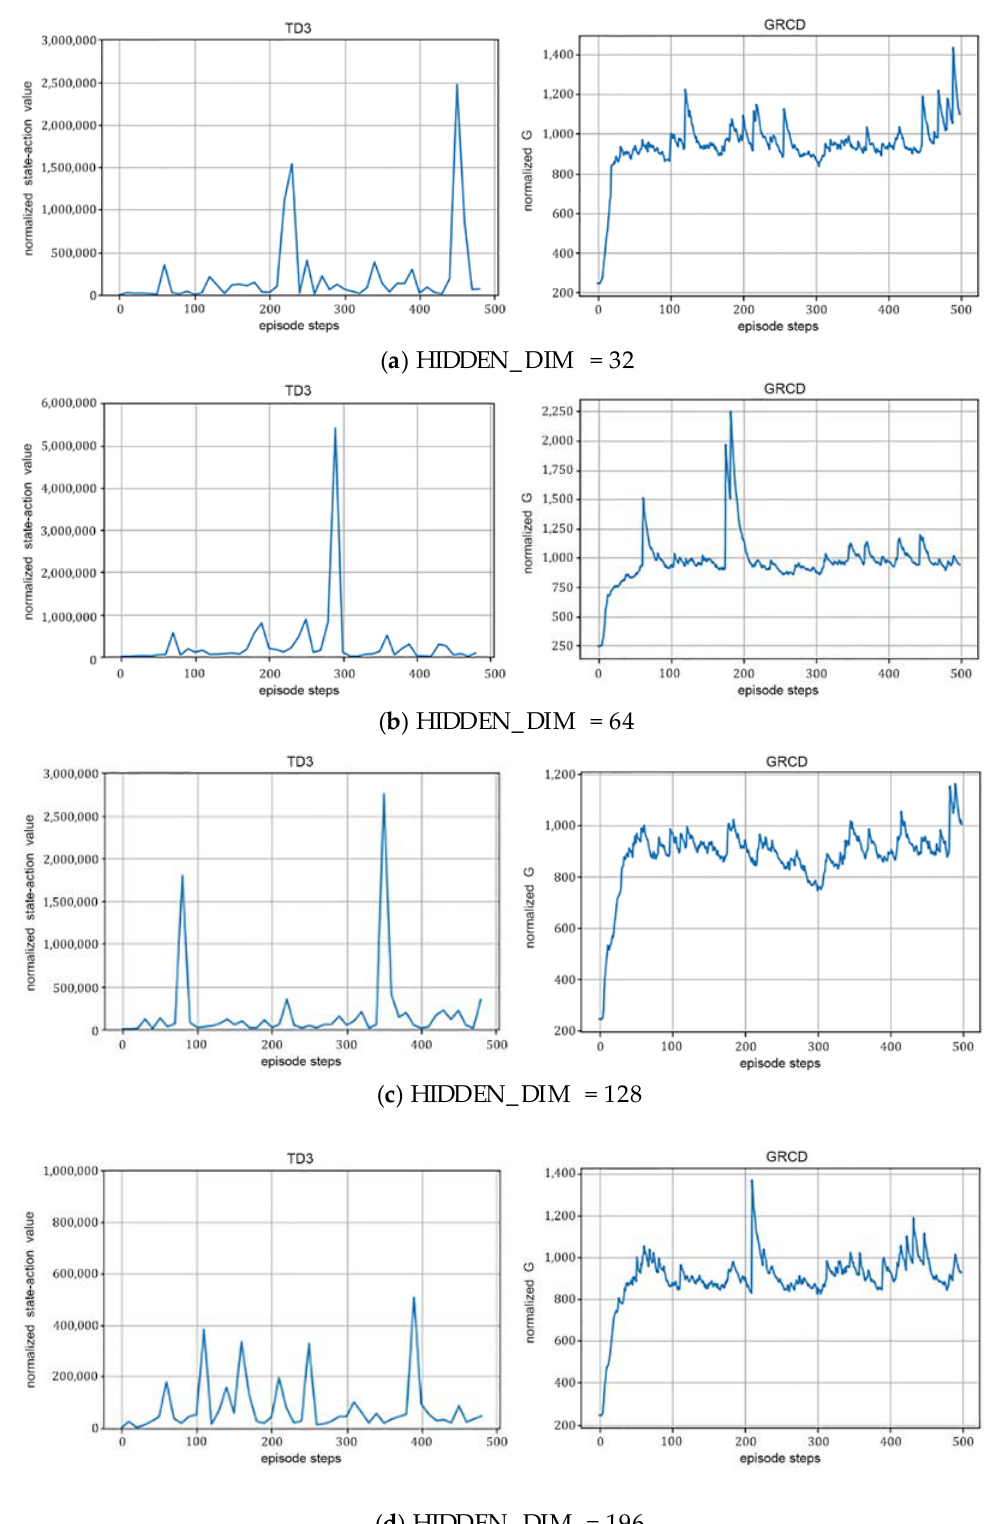
Figure 5. Effect of different hidden layer sizes on the algorithm performance with N = 36, 0.99 γ= .